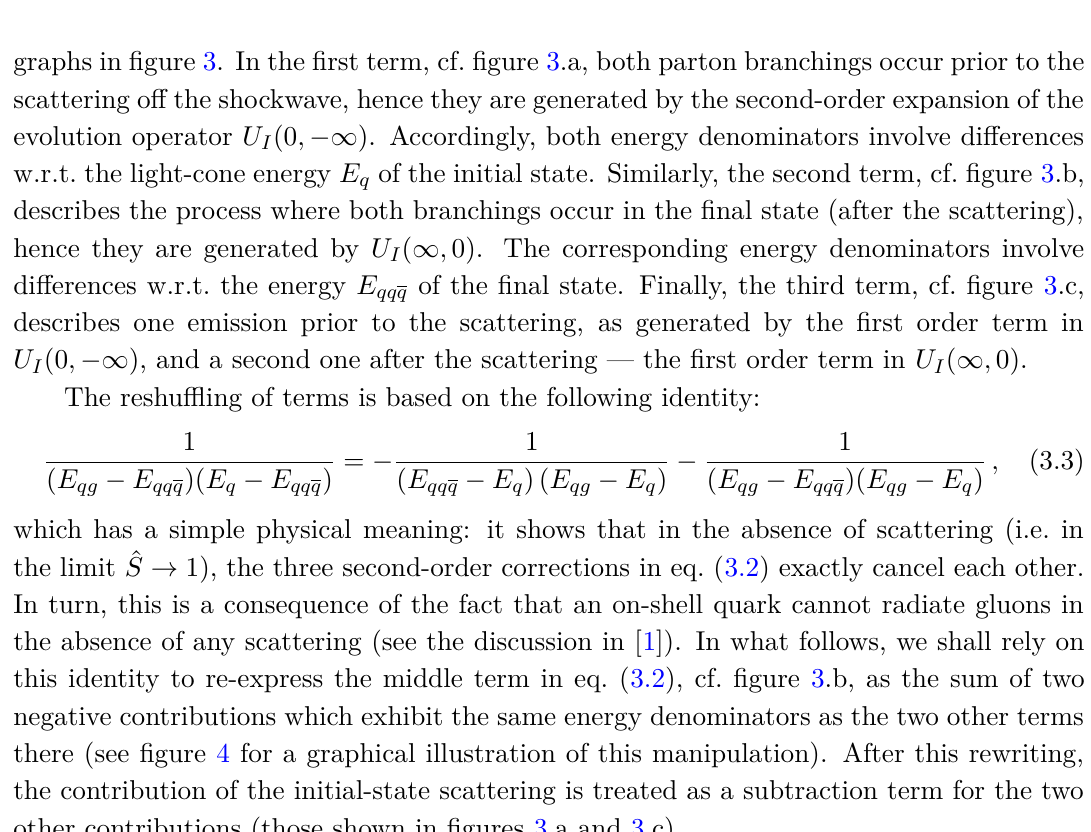
Figure 3 . The three possible configurations for the interplay between parton branching and scat- tering, for a final partonic state built with three quarks: (a) initial-state evolution (the first term in the r.h.s. of eq. (3.2)), (b) mixed evolution: the gluon is emitted prior to the scattering, but it splits after the scattering (the second term in eq. (3.2)), (c) final-state evolution (the third term in eq.